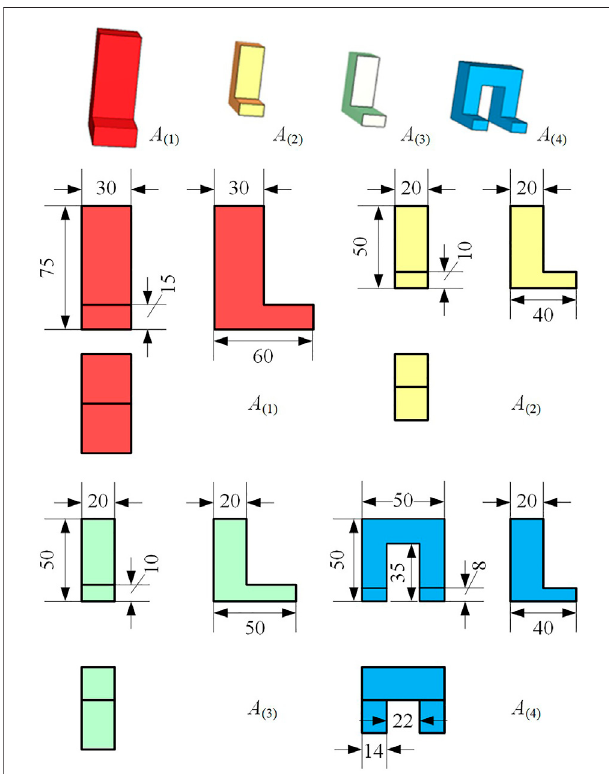
FIGURE 2 | A class of L-shaped object insertion tasks. The shapes and sizes of workpieces are different among tasks, but these tasks possess topologically similar insertion trajectories (unit: mm).